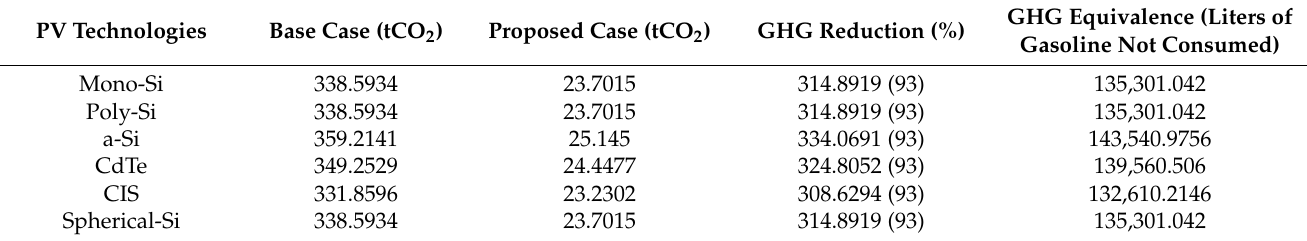
Table 7. Gross annual reduction in GHG emissions of different 600 kW PV technologies in